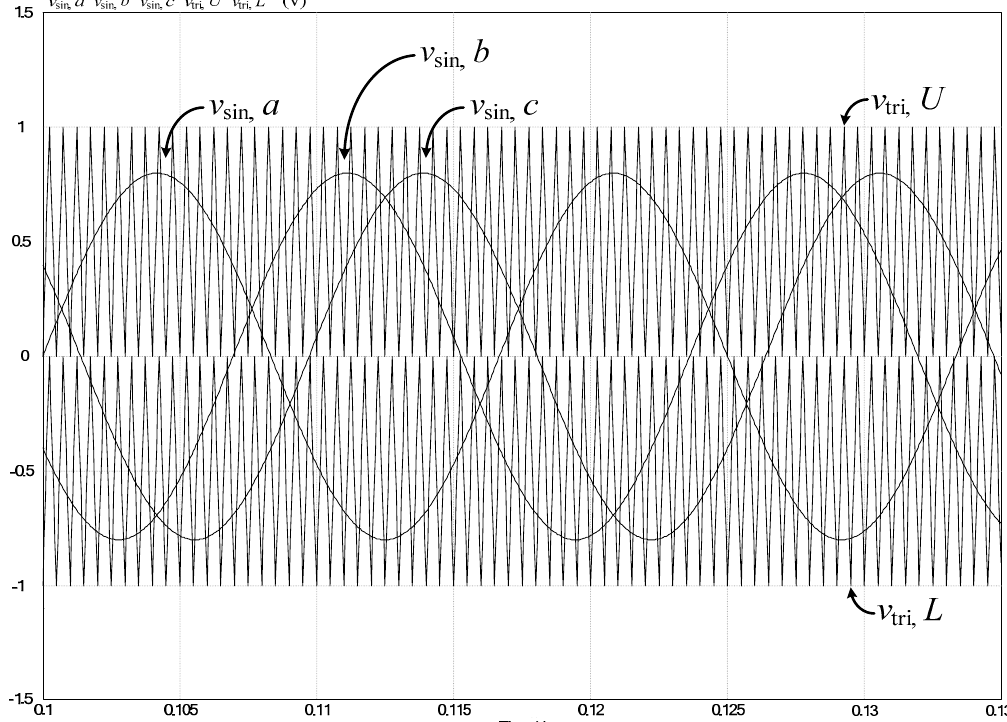
Figure 13. The waveform of pulse width modulation (PWM) control signals for the case of inverter switch S a 1 + with an open-circuit fault.